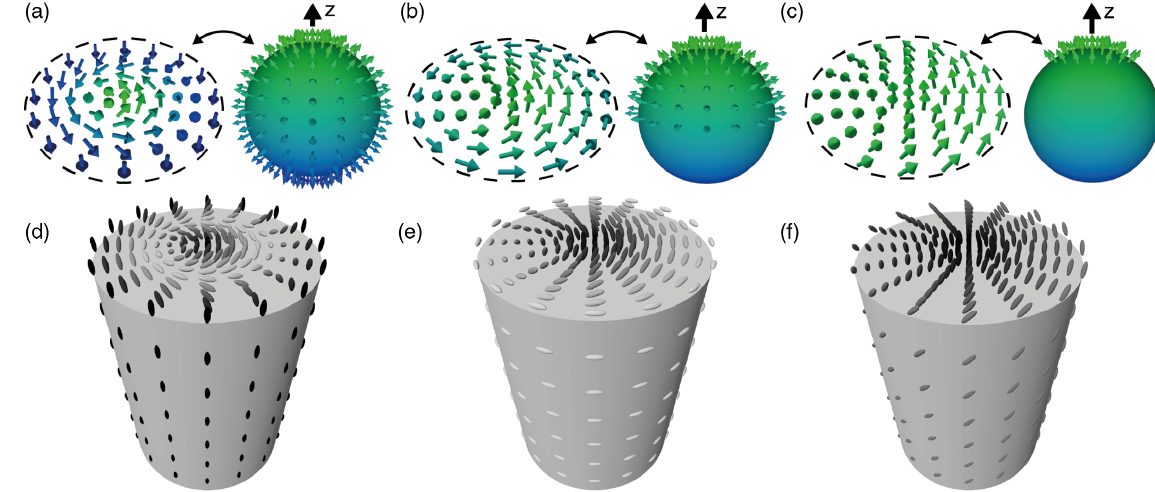
FIG. 1. Full, half-, and quarter-skyrmions in 2D and skyrmion filaments in 3D. (a) 2D vector field structure of a full skyrmion with topological charge q ¼ 1 . The sphere on the right-hand side shows the corresponding vector field mapping on a sphere. The vector field of a full skyrmion (left) assumes every possible orientation in 3D only once, as shown on the sphere. (b) 2D vector field of a half- skyrmion, also named meron, with fractional topological charge of q ¼ 1 = 2 . The vector field of such a skyrmion assumes one-half of possible orientations in 3D space, as shown on the right-hand sphere. (c) 2D vector field of a quarter-skyrmion with fractional topological charge of q ¼ 1 = 4 . (d) – (f) Director field structures n ð r Þ of full-, half-, and quarter-skyrmion filaments, respectively. The local orientation of LC molecules is represented using ellipsoids shaded according to the spatially varying z component, where darker shades denote higher values of the z component (i.e., along the skyrmion filament). The straight filament shown in (f) is also termed the double-twist